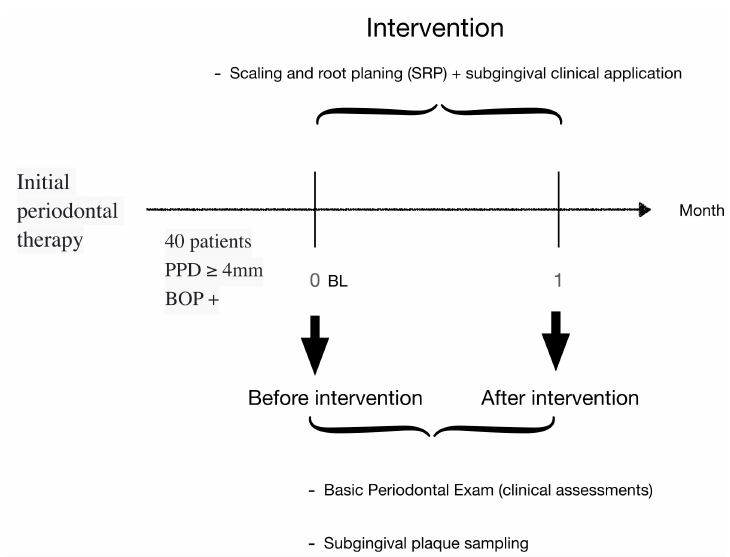
Figure 2. Study design. The registered participants were 40 chronic periodontitis patients who had signed the informed consent. They needed periodontal maintenance therapy and had at least two teeth with bleeding on probing positive (BOP+), probing depths equal or greater than 4 mm (PPD ≥ 4 mm) at baseline (BL). Subgingival plaque samples were obtained with sterile vials from test and control sites at baseline and 1-month